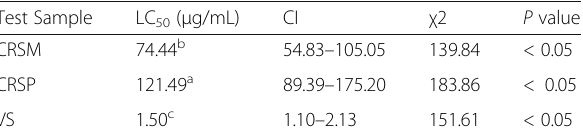
Table 6 Anthelmintic activity of standard drug and sample